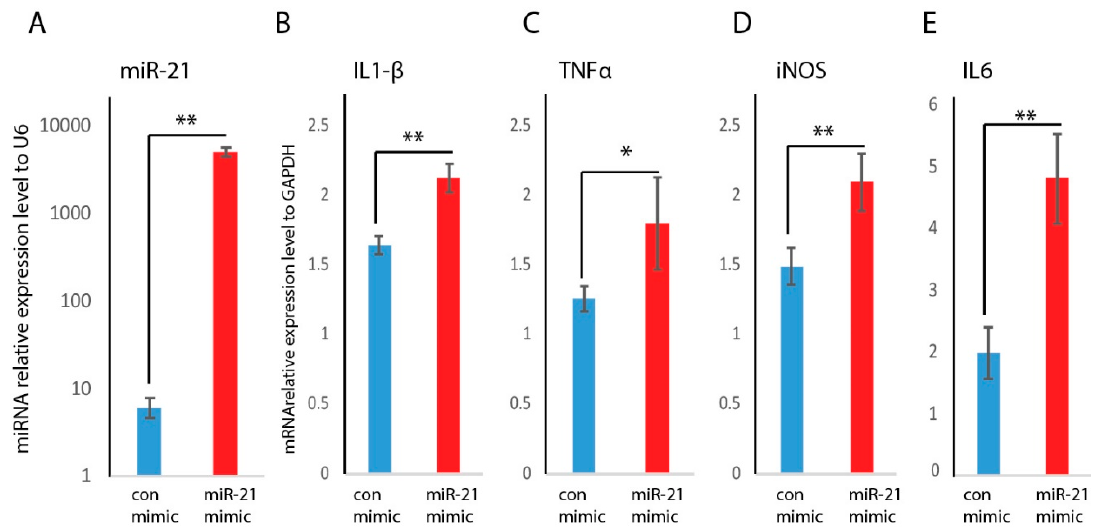
Figure 4. Effects of overexpression of miR-21 on the induction of the pro-inflammatory macrophage phenotype and expression of M1 marker genes. ( A ) Overexpression of miR-21 RNA abundance was achieved by miR-21 mimic transfection and confirmed by RNA analyses by RT–qPCR (mean + SD, n = 3 per group), miR-21 abundance was significantly induced in the RAW macrophages transfected with miR-21 mimic compared to mimic control. M1 marker genes IL1-beta ( B ), TNFa ( C ), iNOS ( D ), and IL6 ( E ) were induced following transfection of RAW macrophages with miR-21 mimic (mean + SD, n = 5 per group, (** p < 0.01, * p < 0.05).